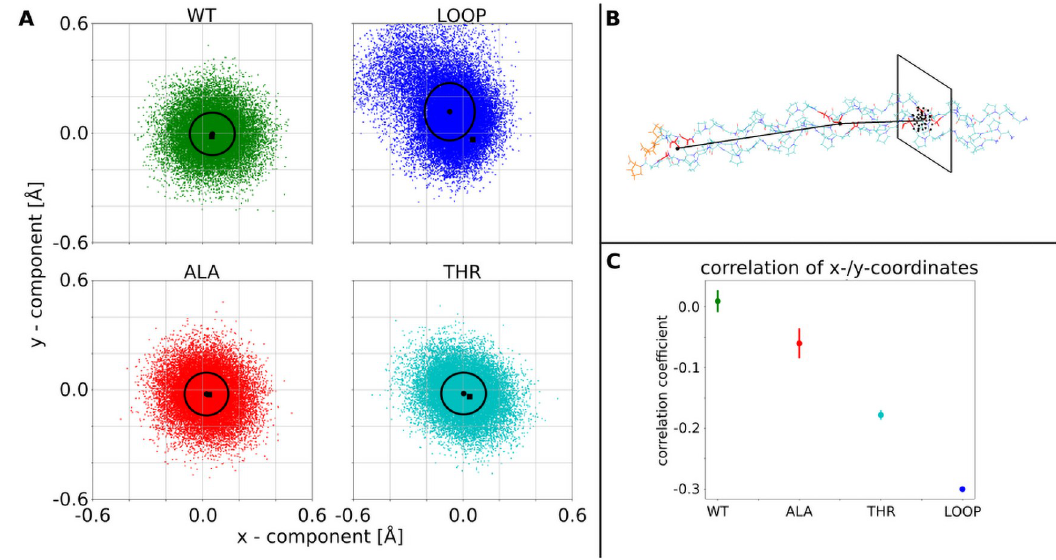
Fig 7. Influence of central G ! A/T substitution in one chain or loop in one chain on the flexibility of the triple helix. (A) Each point in the 4 plots is the projection of a vector from the center of the folded triple helix to the N-Terminus on the plane perpendicular to the vector pointing from the C-Terminus to the center of the triple helix. WT indicates the natively folded triple helix with an isotropic distribution indicating a fluctuation around the straight triple helix (standard deviation of the distribution indicated as black circle). The LOOP, ALA, THR label indicate simulations with a central loop segment of one chain (see also Fig 6A), a central G ! A or G ! T mutation in one strand, respectively. The LOOP case indicates a significant directional bending fluctuation. (B) illustration of the vectors and projection. (C) correlation of x/y-displacement for the wild type, the single G7aA and G7aT mutations and the triple helix with the looped out segment in one chain. Increased correlation indicates anisotropic bending fluctuations of one end of the triple helix relative to the other